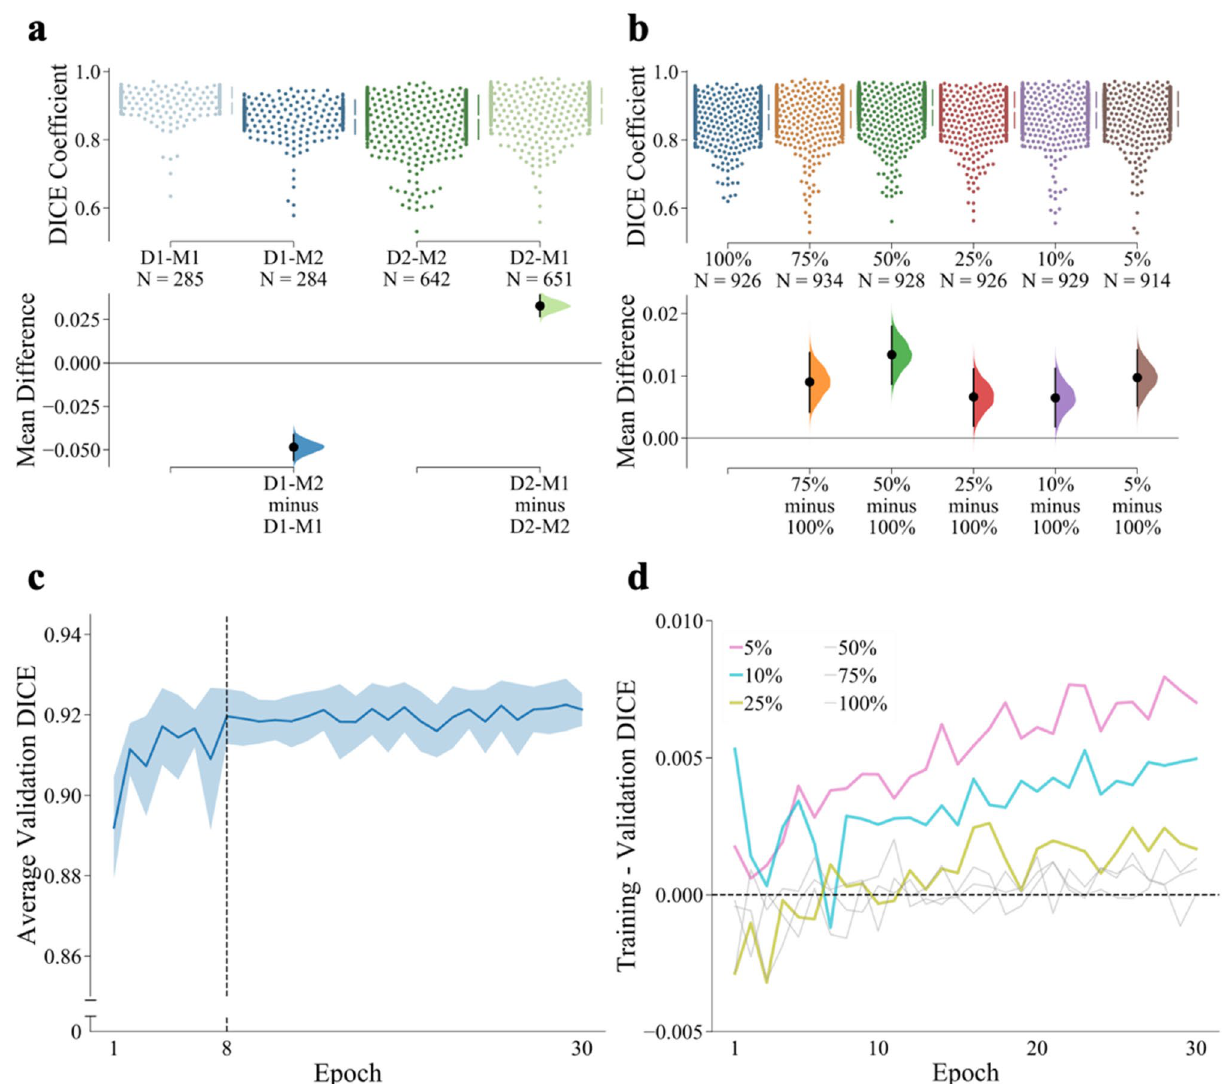
Figure 5. ANMAF was generalizable and trainable with a low number of human-labeled neurons in a few iterations. ( a ) Cumming estimation plot comparing the performance on learning synthetic data sets generated using different data sources. M1 was trained on synthetic images generated solely from somatic regions in D1, whereas M2 was trained on synthetic images produced using somatic areas from D2. D1 and D2 represent two different sets of Clomeleon expressing neurons in acute brain slices using two different two-photon microscopes. Upper axes, raw data. Each data point represents a matched somatic region between the human annotator and the model. SD are shown as gapped lines to each group’s right, and the mean of each group is indicated as a gap in the line. Each mean difference is plotted on the lower axes as a bootstrap sampling distribution. Mean differences of DICE coefficients between two groups are depicted as dots; 95% confidence intervals are indicated by the ends of the vertical error bars. N represents the number of human-annotated neurons that a model detects. ( b ) Cumming estimation plot comparing the performance on learning synthetic data sets generated using a different number of real neurons from D1 and D2. Graph details as A. ( c ) Average performance of the different ANMAF models (solid blue line). The shaded blue area covers one standard deviation below and above the average performance. ( d ) Difference between training and validation DICE coefficients when using a different number of training neurons. Note that the highest difference with 5% and 10% represents a thousandth of a unit change in the DICE